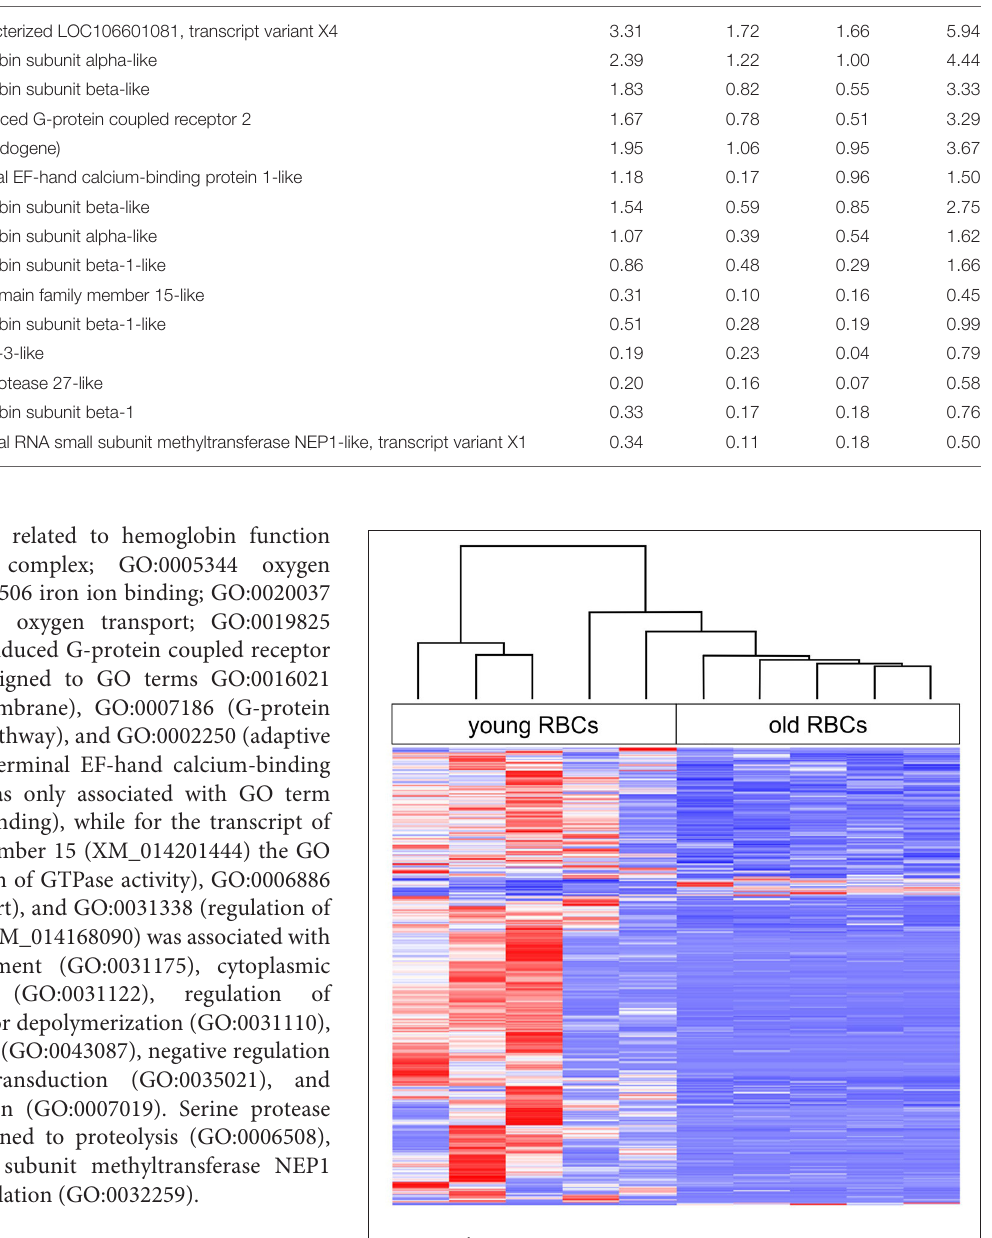
with the highest log 2 -fold changes were the transmembrane